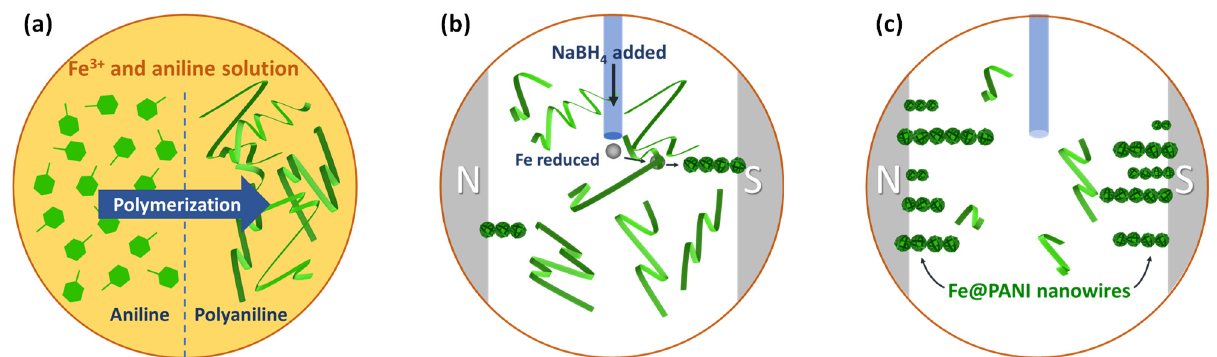
Figure 1. Schematic illustrations of this one-pot Fe@PANI core–shell nanowire preparation process. ( a ) Aniline monomers were polymerized into polyaniline (PANI) by Fe 3+ ions. ( b ) Fe 3+ ions were reduced into Fe nanoparticles with NaBH 4 addition. Fe nanoparticles were attracted and aligned by magnetic field. ( c ) Ribbon-like PANI enveloped Fe NW to form Fe@PANI core–shell nanowires.